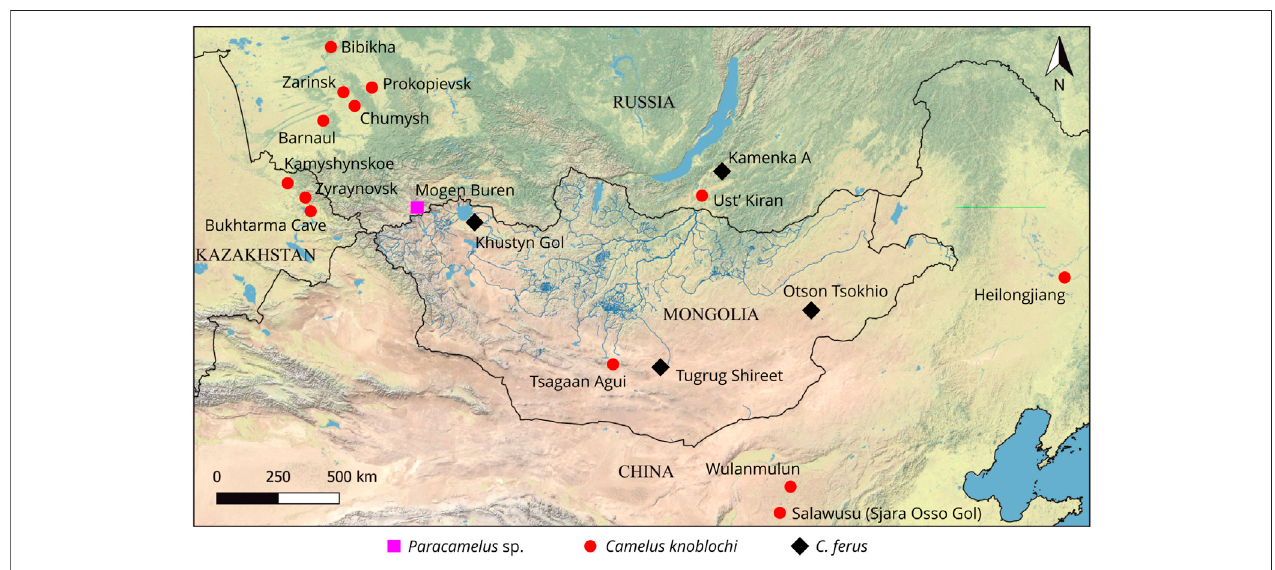
FIGURE 1 | Principal fi nds of fossil camels in eastern